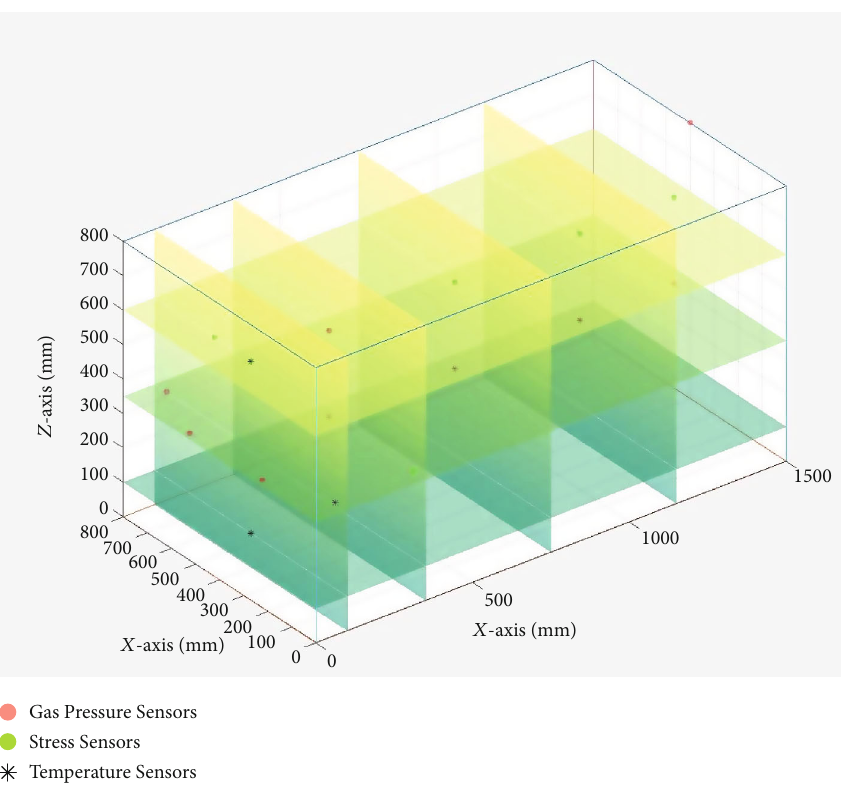
Figure 2: Position of the sensor in similar